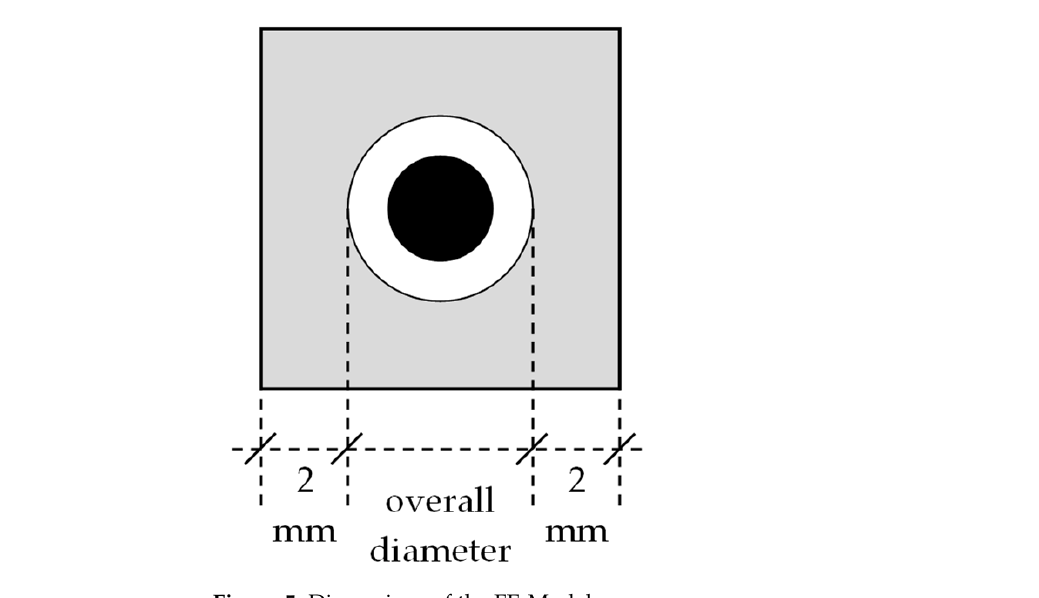
Figure 5. Dimensions of the FE-Model.